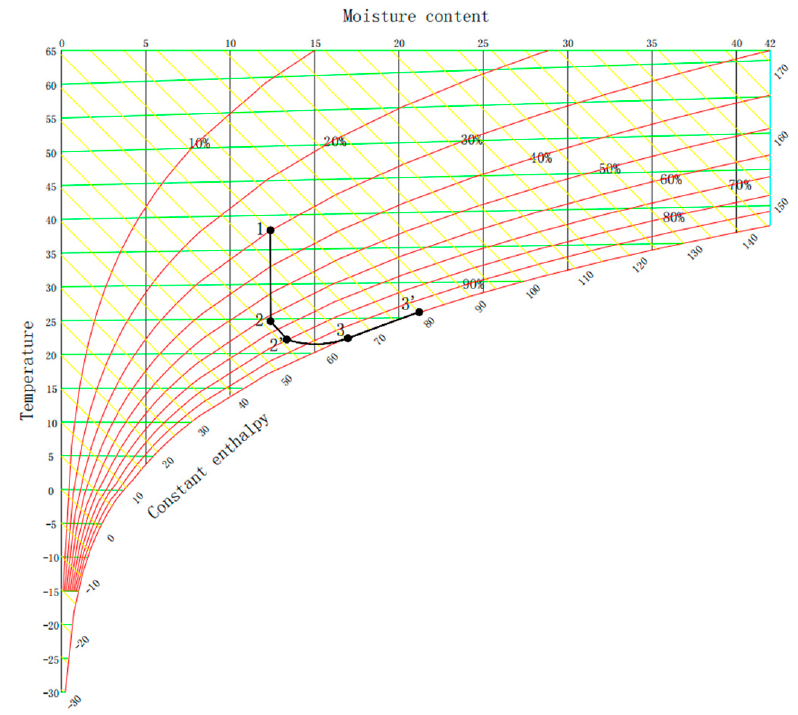
Figure 2. The theory of dew-point evaporative cooling.